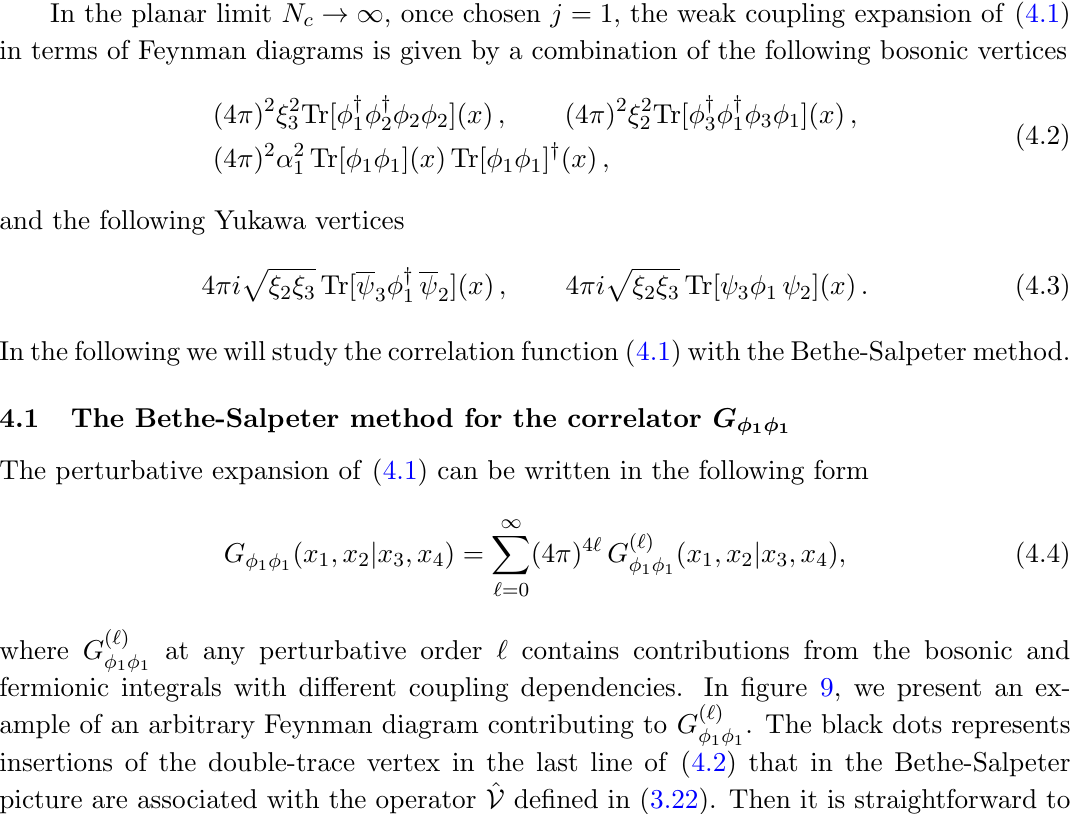
Figure 9 . A Feynman diagram contributing to the perturbative expansion G ( ‘ ) dots stand for double-trace vertices and tick and dashed lines correspond to bosonic and fermionic propagators respectively. The colors represent di(cid:11)erent (cid:13)avors j of the particles (cid:30) j and j : in particular black for j = 1, red for j = 2 and green for j = 3. The propagators are not crossing and are curved to stress the fact that they have a cylindrical